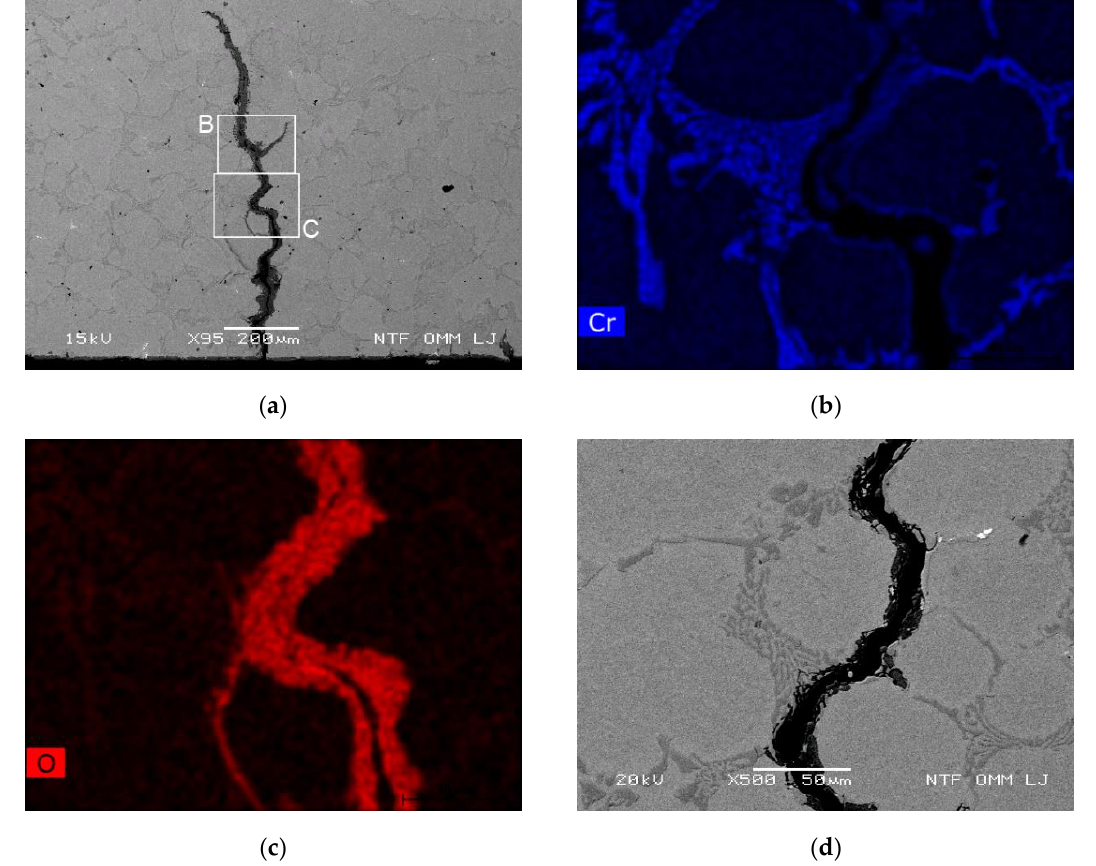
Figure 10. Influence of the medium effective thermal stress on the oxidation behavior: ( a ) micrograph of the oxidized crack canal—marked areas B (Figure 14c) and C (EDX elemental maps in the subfigures b and c); ( b ) distribution of Cr; ( c ) distribution of O; and ( d ) typical appearance of the crack and oxide following the carbide pathway at the medium effective thermal stress after 2500 cycles at 700 °C.